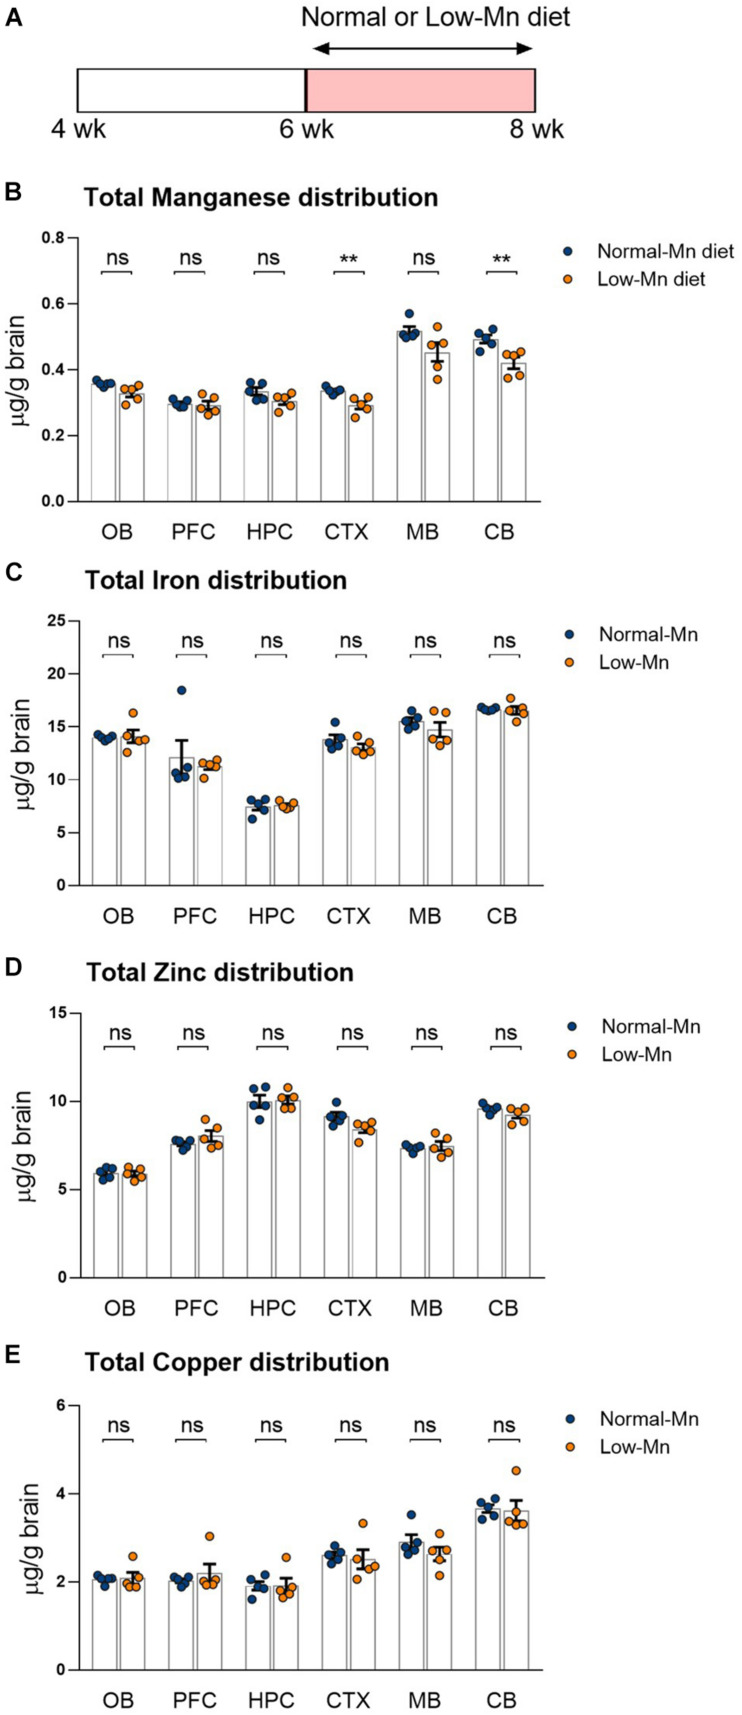
Dietary manganese (Mn) depletion reduces brain Mn levels. (A) Experimental scheme to analyze the transcriptome in low-Mn or normal-Mn diets fed mice. Mice were fed with either low-Mn or normal-Mn diets (0 and 35 mg/kg Mn, respectively). (B–E) Levels of the trace elements Mn, iron (Fe), zinc (Zn), and copper (Cu) were measured by inductively coupled plasma mass spectrometry (ICP-MS) in the brain regions of mice (n = 5 per group). Data represent means ± SEM. ** P < 0.01.